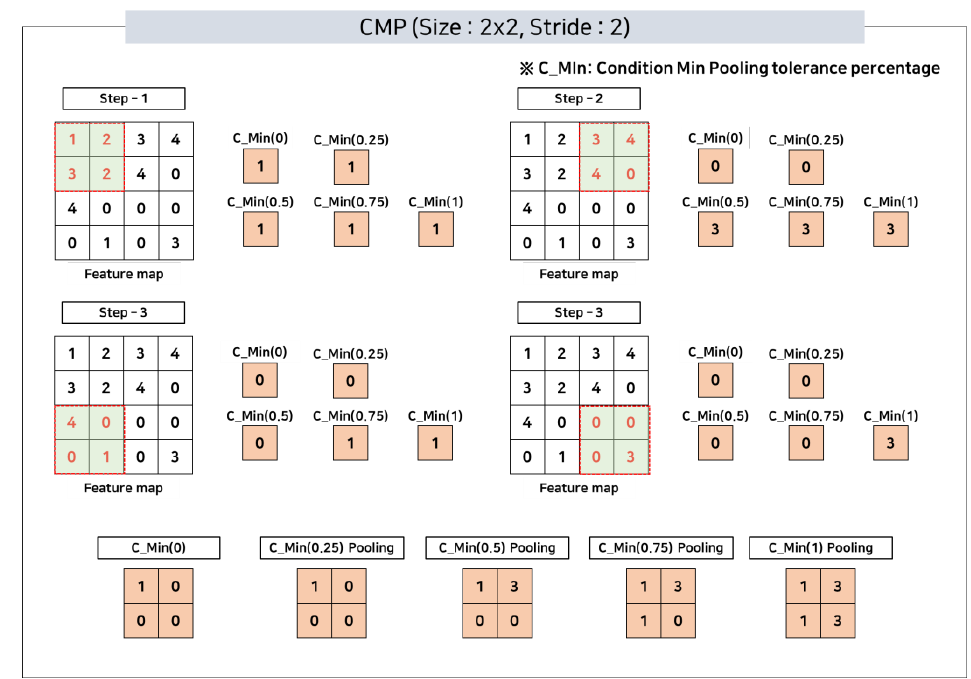
Figure 3. Proposed pooling structure of method.